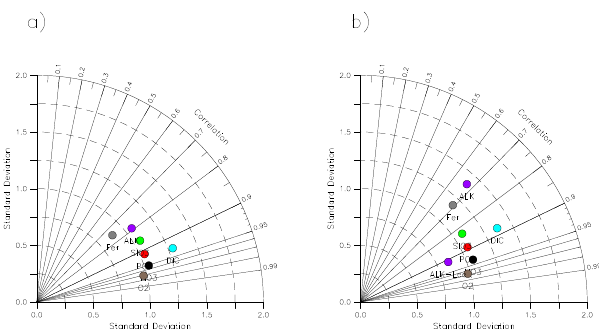
Figure 16. Taylor diagrams of model–observation comparisons for nutrients using monthly mean fields. The data are identical to those used in previous plots. Panel (a) corresponds to the global ocean. Panel (b) shows the comparison restricted to the top 100m of the ocean. Black dot corresponds to NO 3 , brown dot to O 2 , red dot to PO 4 , green dot to SiO 3 , light-blue dot to DIC, purple dot to alkalin- ity and gray dot to iron. The additional purple dot labeled as Alk- Lee uses the database constructed by Lee et al. (2006) to compare with the